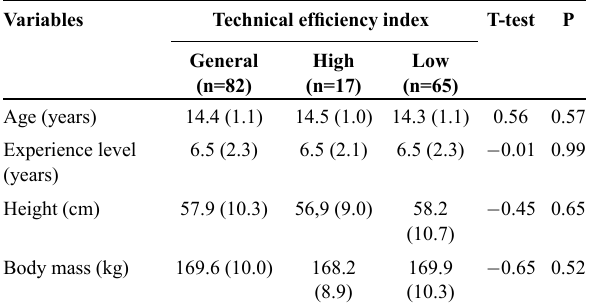
Table 1 - Characteristics of the participants by groups of High- and Low- frequency of technical actions.